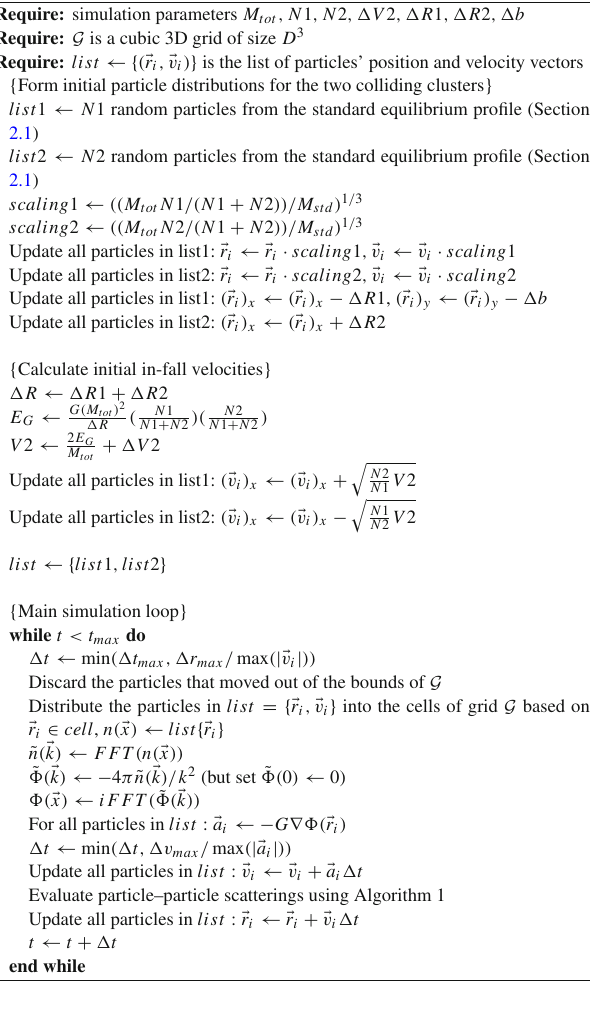
Algorithm 2 Particle Mesh algorithm for N -body gravita- tional